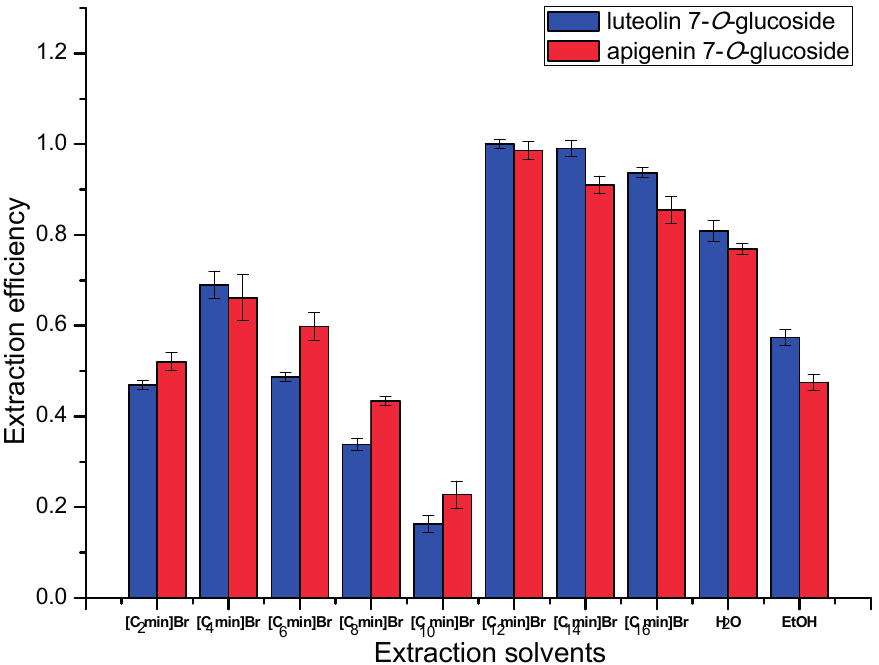
Figure 4. Extraction efficiency comparison of IL aqueous solutions with the blank control